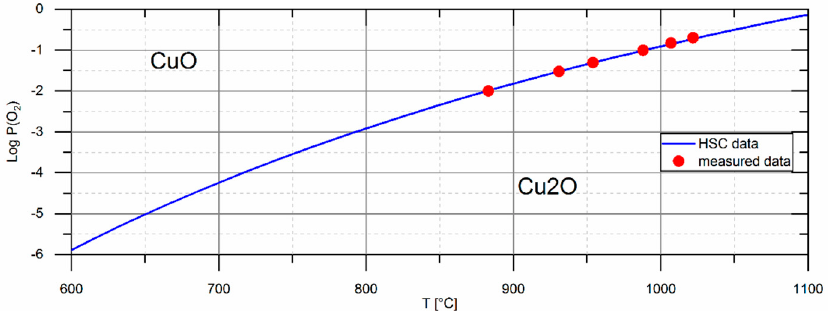
Figure 3. Comparison of the equilibrium oxygen pressure resulting from the HSC database [49] and the experimental data for Cu 2 O/CuO.